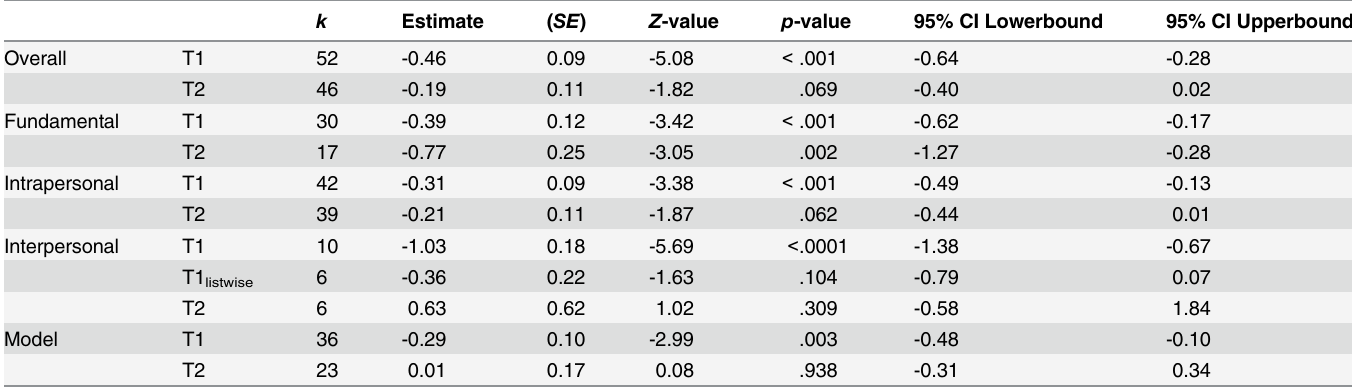
Table 3. Interaction effect per